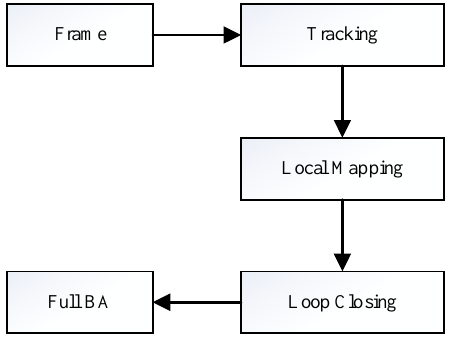
Figure 1. The system framework of ORB-SLAM2.